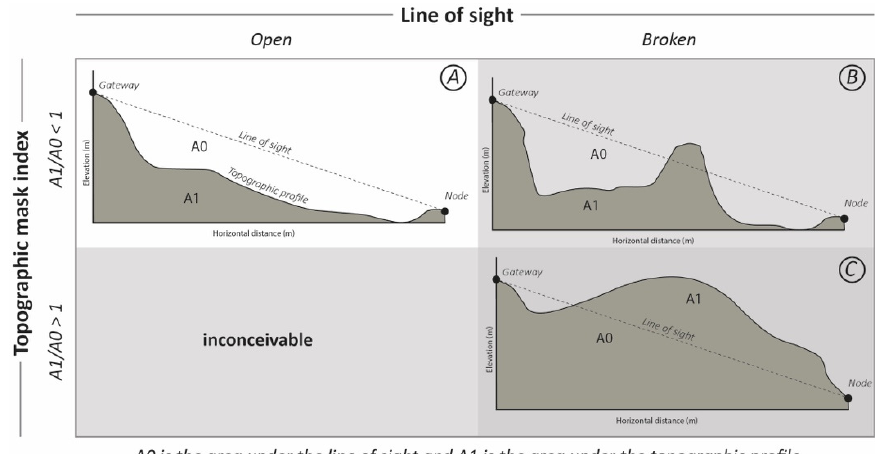
Figure 15. Classification classes for the nodes.